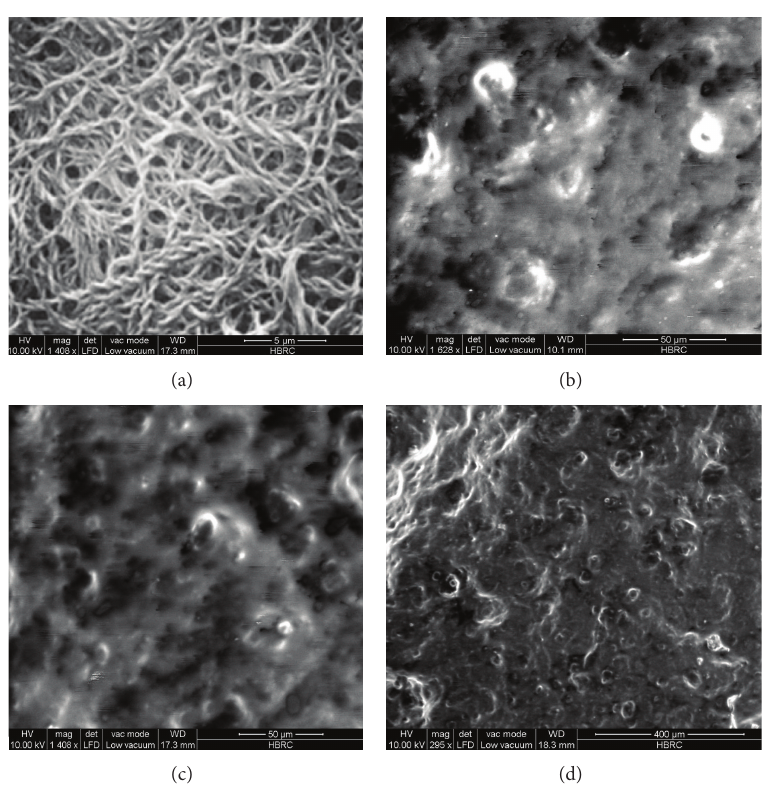
Figure 3: SEM image of grease with (a) base grease, (b) 0.5% CNTs, (c) 1% CNTs, and (d) 2% CNTs.